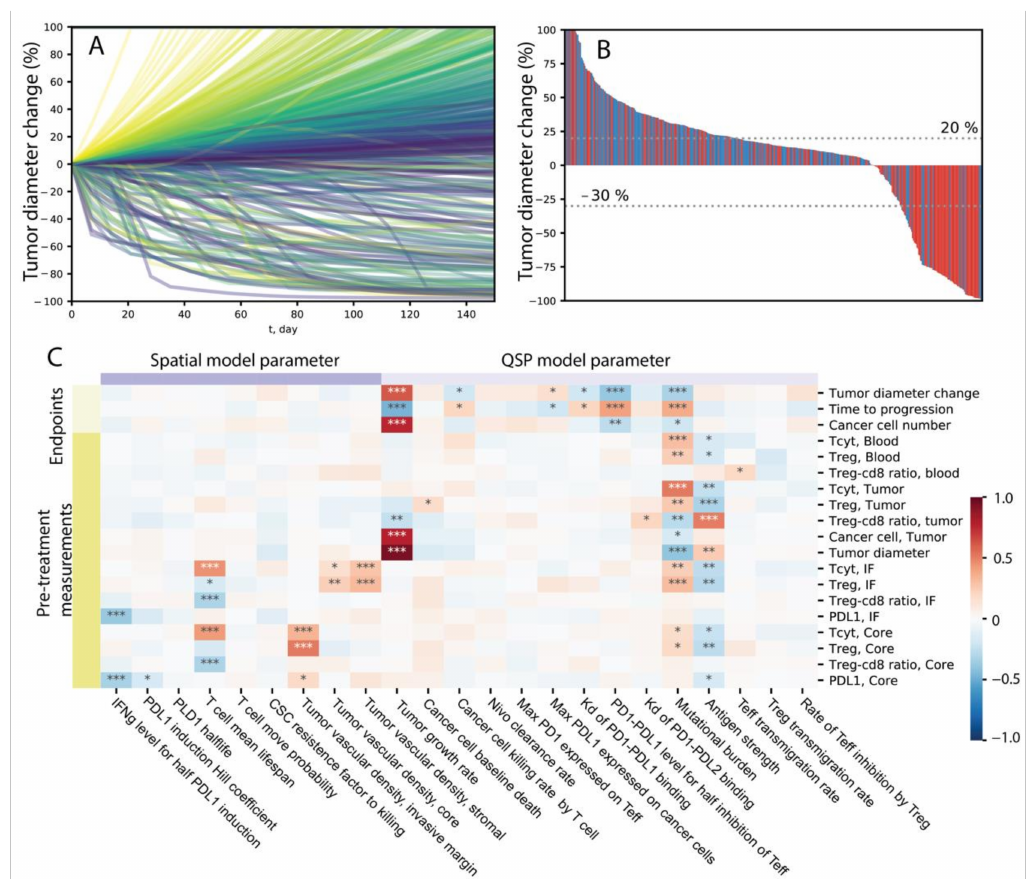
Figure 5. Response to treatment in a virtual cohort and parameter sensitivity. ( A ) Tumor diameter change, relative to diameter prior to first drug administration. Colors correspond to tumor growth rate, with red representing high growth rate and purple representing low growth rate. ( B ) Best response measured as minimum tumor diameter changes from 8 weeks after the first drug administration. Colors represent tumor mutational burden, where red indicates the patient has a mutational burden higher than median value among the cohort and blue indicates a mutational burden lower than median. ( C ) PRCC of simulation output against different parameters. *, ** and *** indicate p -values smaller than 10 − 3 , 10 − 6 and 10 − 9